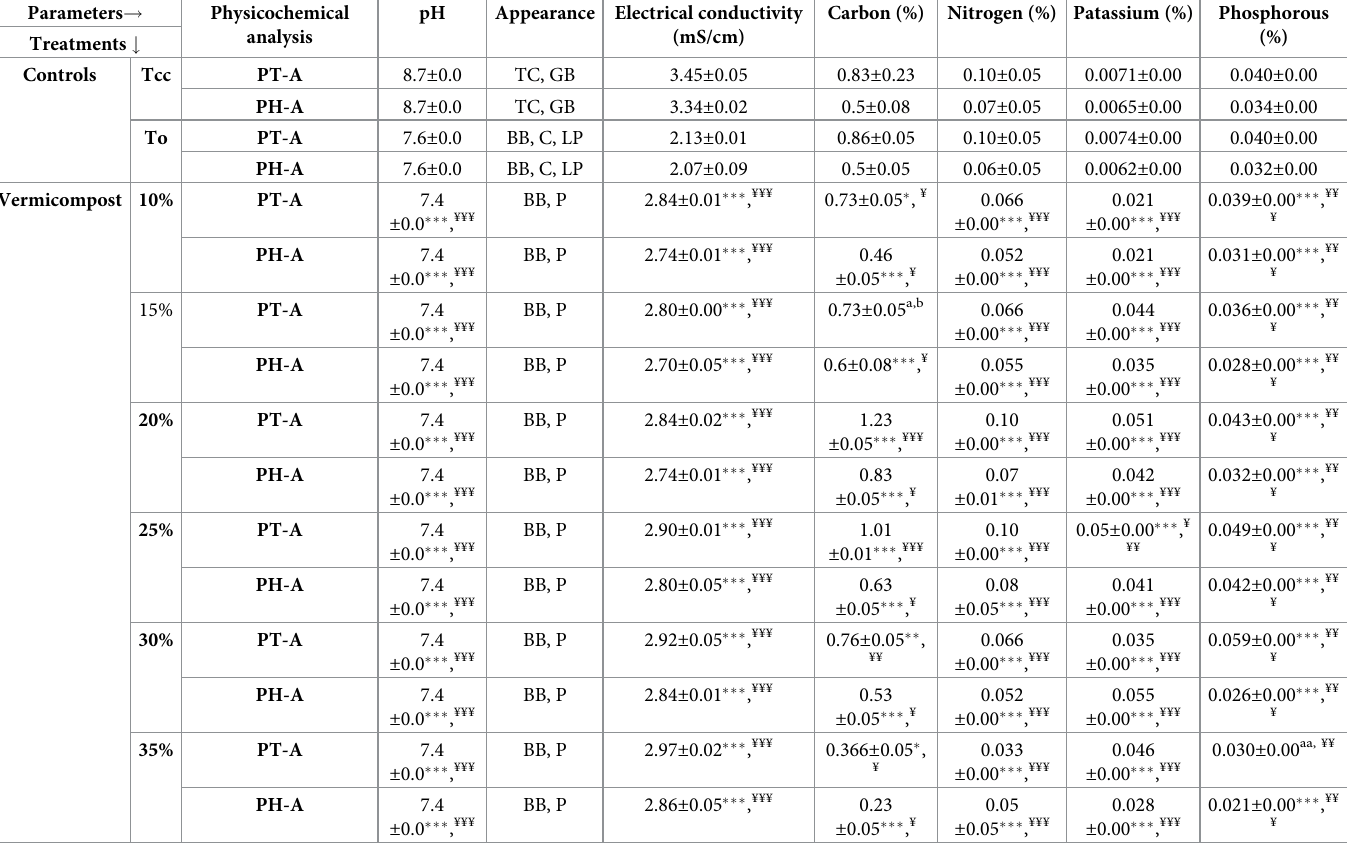
Table 4. Pre and post physicochemical examination of germinating media used for pansy vegetative growth parameters. Parameters ! Physicochemical analysis